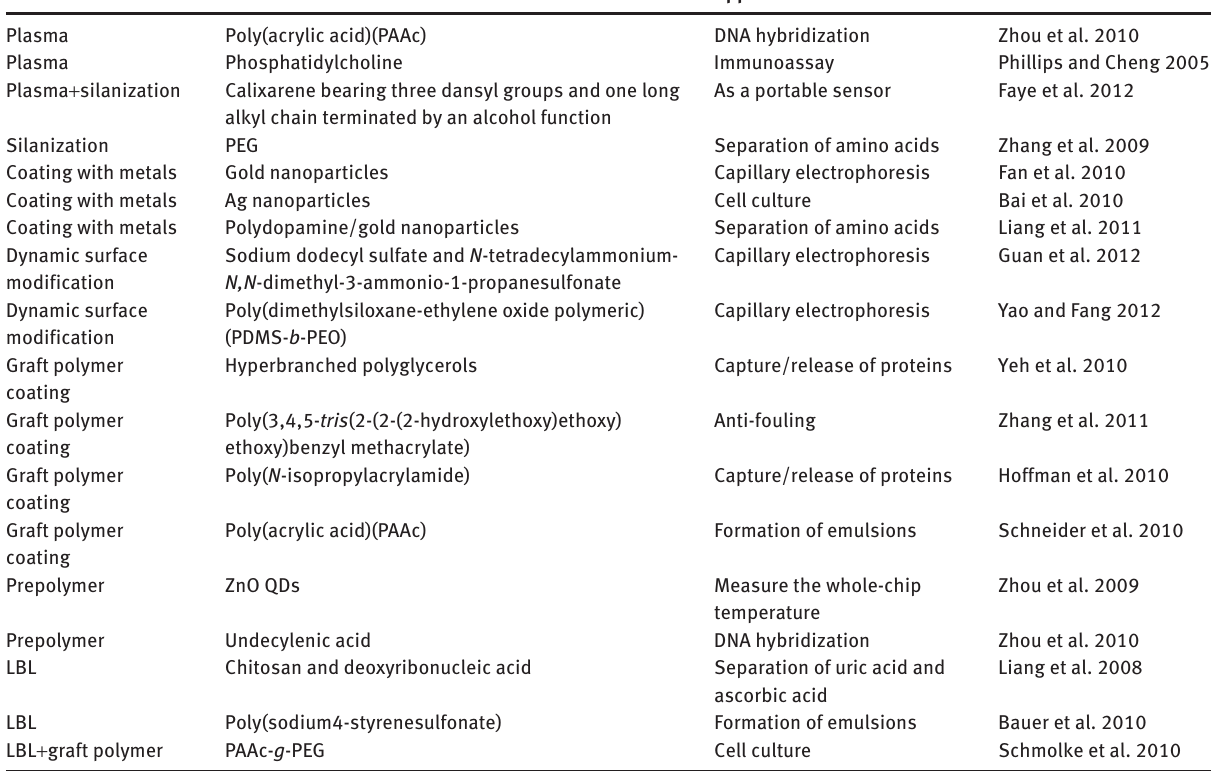
Table 1 Summary of the applications of PDMS surface modification in biological